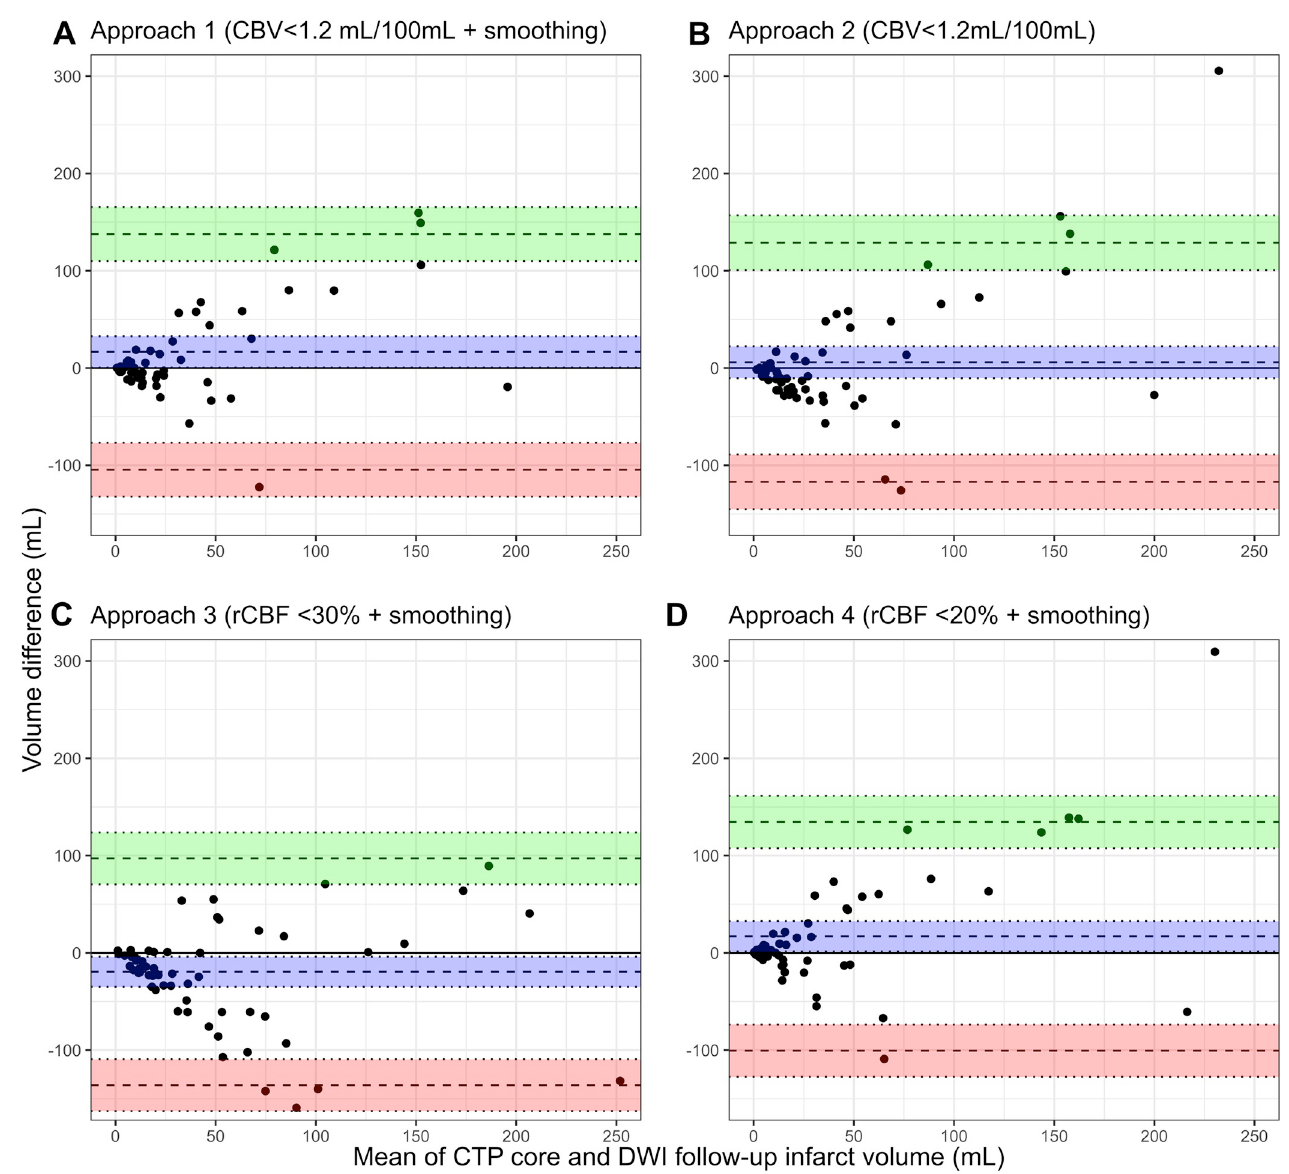
Fig 2. Bland-Altman plots comparing the estimated CTP ischemic core volume and DWI follow-up infarct volume for (a) approach 1, (b) approach 2, (c) approach 3, and (d) approach 4. The mean bias (blue), lower (red) and upper (green) Limits of Agreement are shown with 95% confidence intervals. The bias with 95% confidence intervals is shown in blue. Negative values indicate overestimation by CTP. CTP = CT perfusion; DWI = diffusion weighted